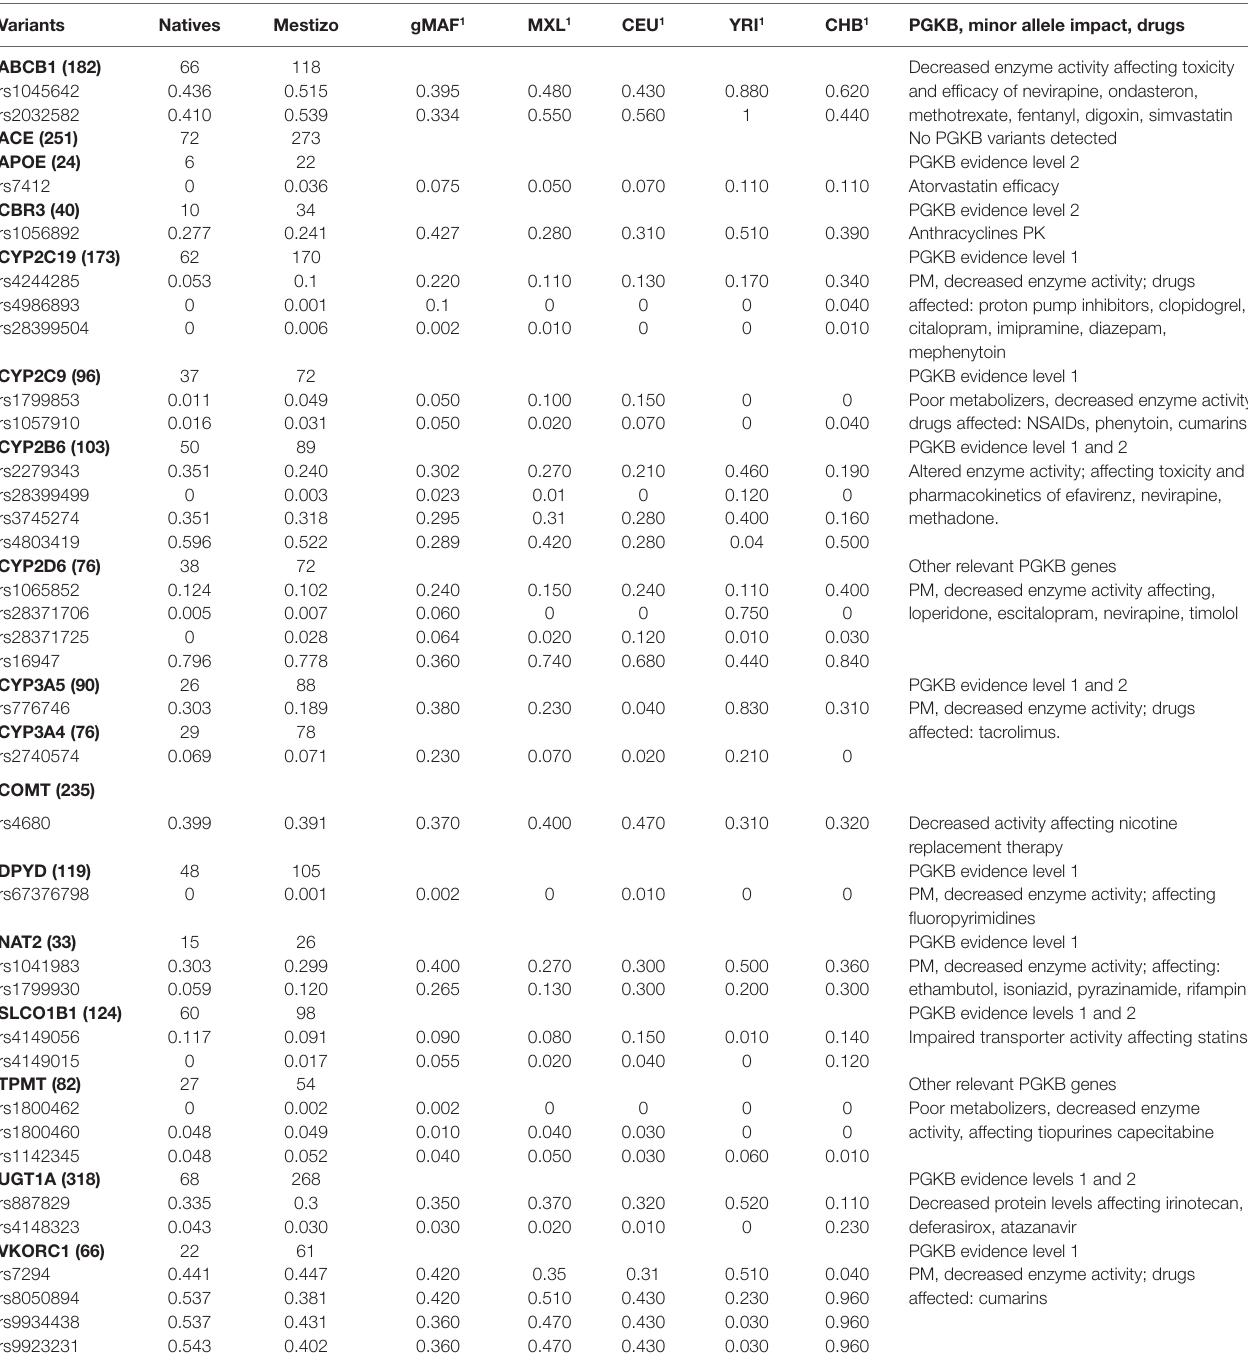
TABLE 2 | Allele frequencies for 17 actionable pharmacogenetic variants.